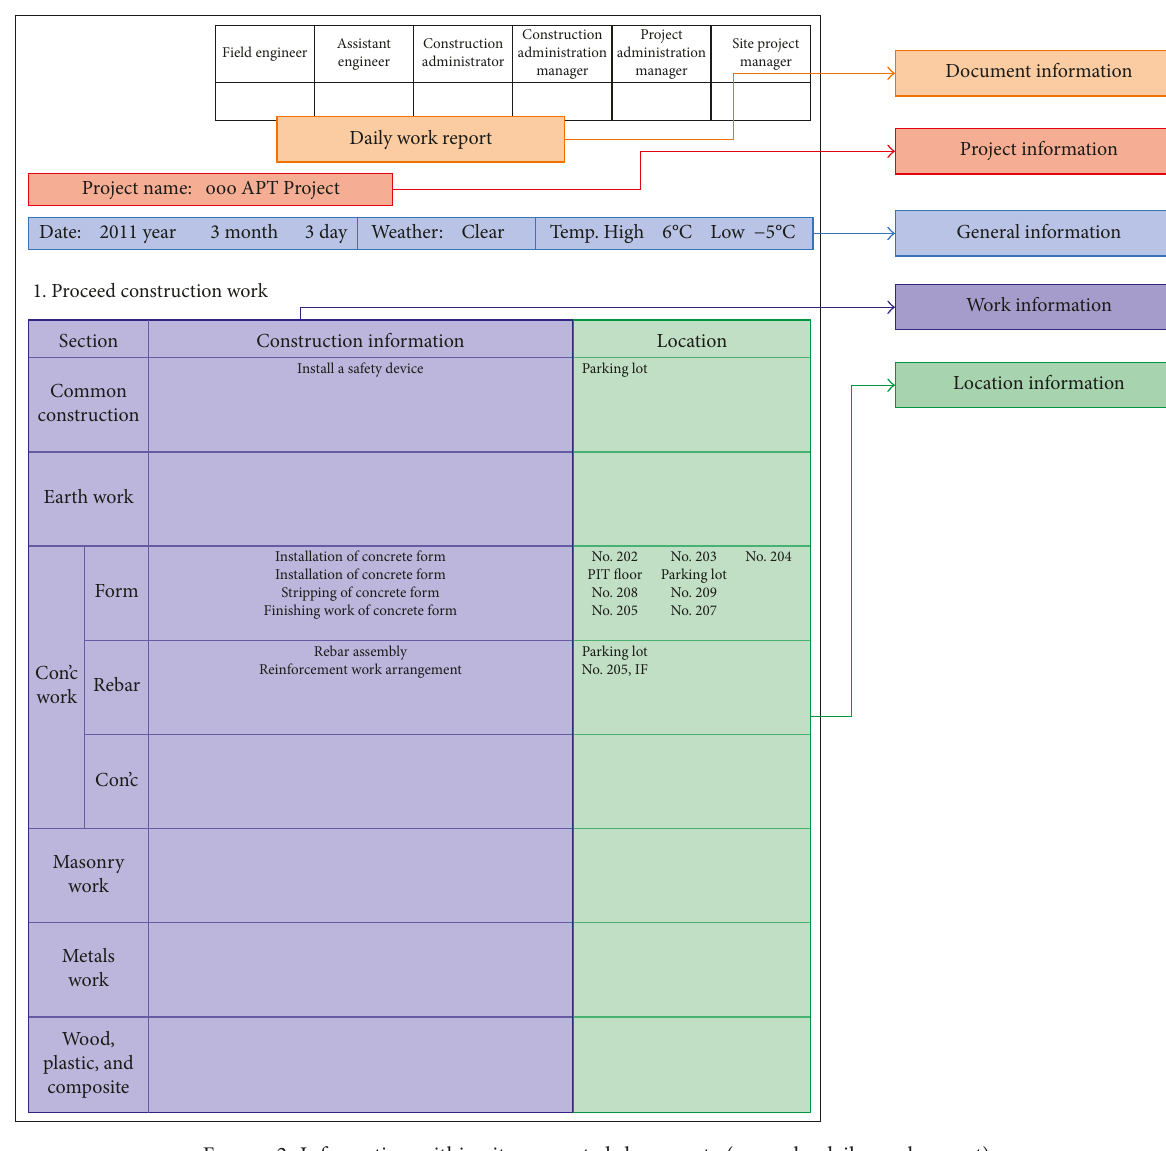
Figure 2: Information within site-generated documents (example: daily work